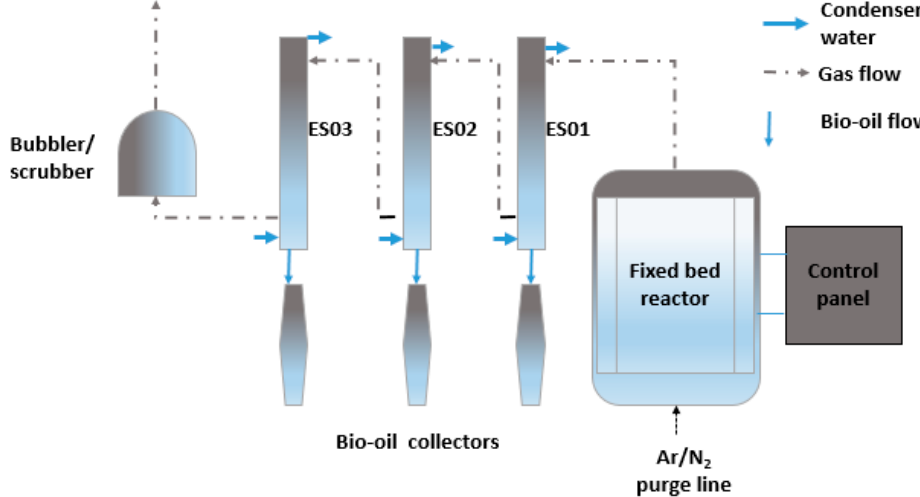
Figure 1. Schematic for the fixed bed pyrolysis Figure 1 . Schematic for the fixed bed pyrolysis unit .